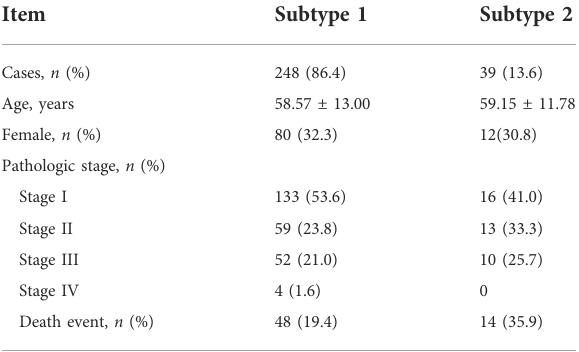
TABLE 1 Clinical characteristics of HCC subtypes.